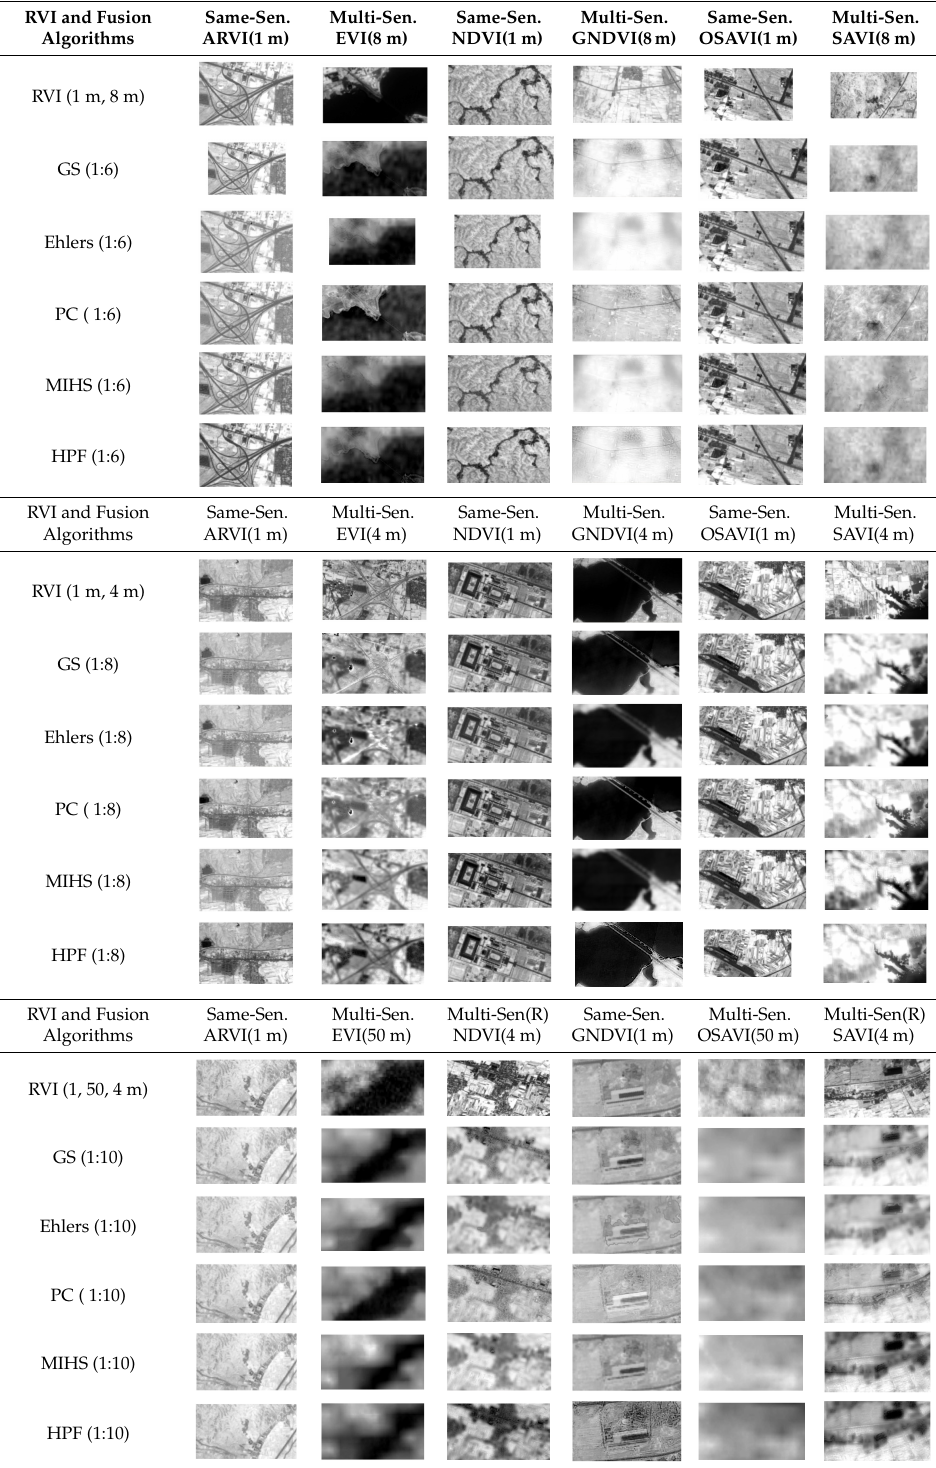
Table 8. Visual quality of FVI result in single / multi-sensor fusion.